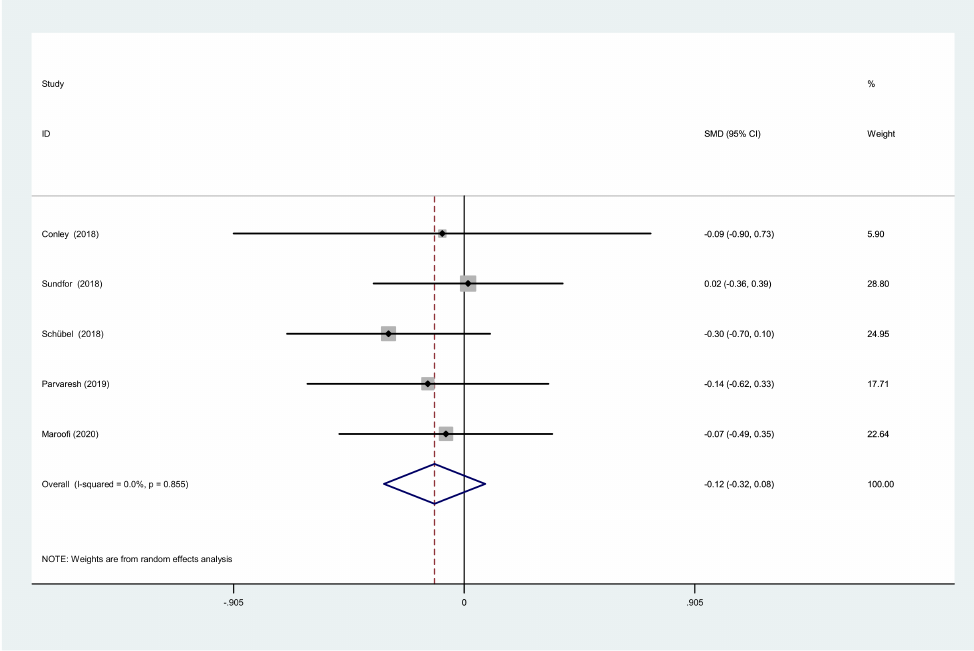
Figure 7. Forest plot of meta-analysis on comparing TG changes after IF and CCR